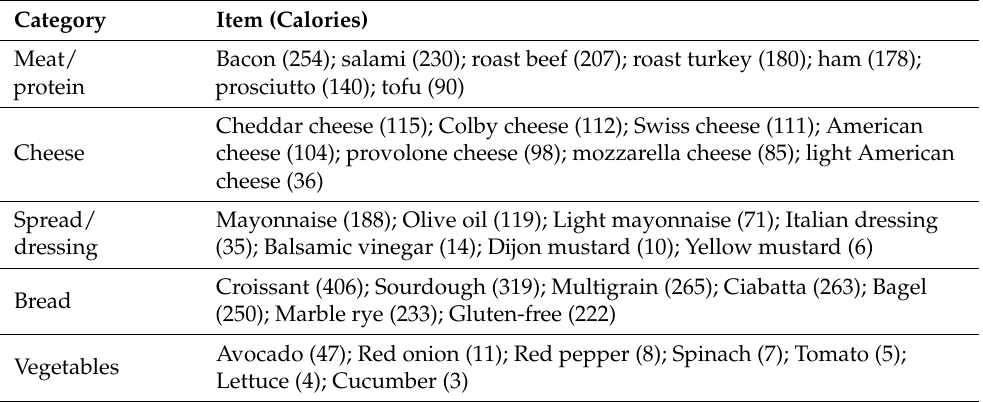
Table 1. Sandwich ingredients and calories in food choice